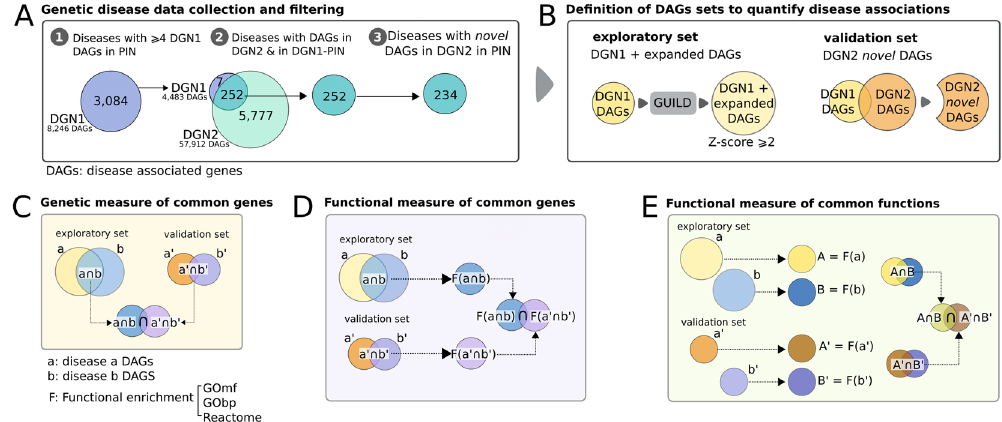
Figure 1. Schema of data collection and methods applied. ( A ) Disease data collection and filtering (left panel). Venn diagrams show the number of diseases in DGN1 and DGN2, for the diseases having at least four disease- associated genes (DAG). ( B ) Schematic representation of the exploratory and validation sets. Methods to quantify disease relationships: ( C ) Genetic score of common genes: a ′ ∩ b ′ and a ∩ b are the common DAGs of diseases “a” and “b” in the validation and exploratory sets, respectively. The intersection of both sets is used to compute the p-value with respect to a background of genes. ( D ) Functional score of common genes: a ′ ∩ b ′ and a ∩ b are defined as before, while F(a ∩ b) and F(a ′ ∩ b ′ ) are the sets of functions enriched with genes in a ∩ b and a ′ ∩ b ′ , respectively. The set of significant common enriched-functions (after multiple testing correction) is used to compute the p-value of this relationship with respect to a background set of functions. ( E ) Functional score of common functions: We first find the set of functions enriched among the DAGs of diseases “a” and “b” in the exploratory ( A and B ) and validation (A ′ and B ′ ) sets;. Next, we extract the set of common functions of diseases “a” and “b”, A ∩ B and A ′ ∩ B ′ respectively. The final p-value of the relationship is then calculated with the set of significant common enriched-functions (after multiple testing correction) with respect to a background set of functions. A multiple testing correction is applied after computing final p-values of scoring methods introduced in C to E (see